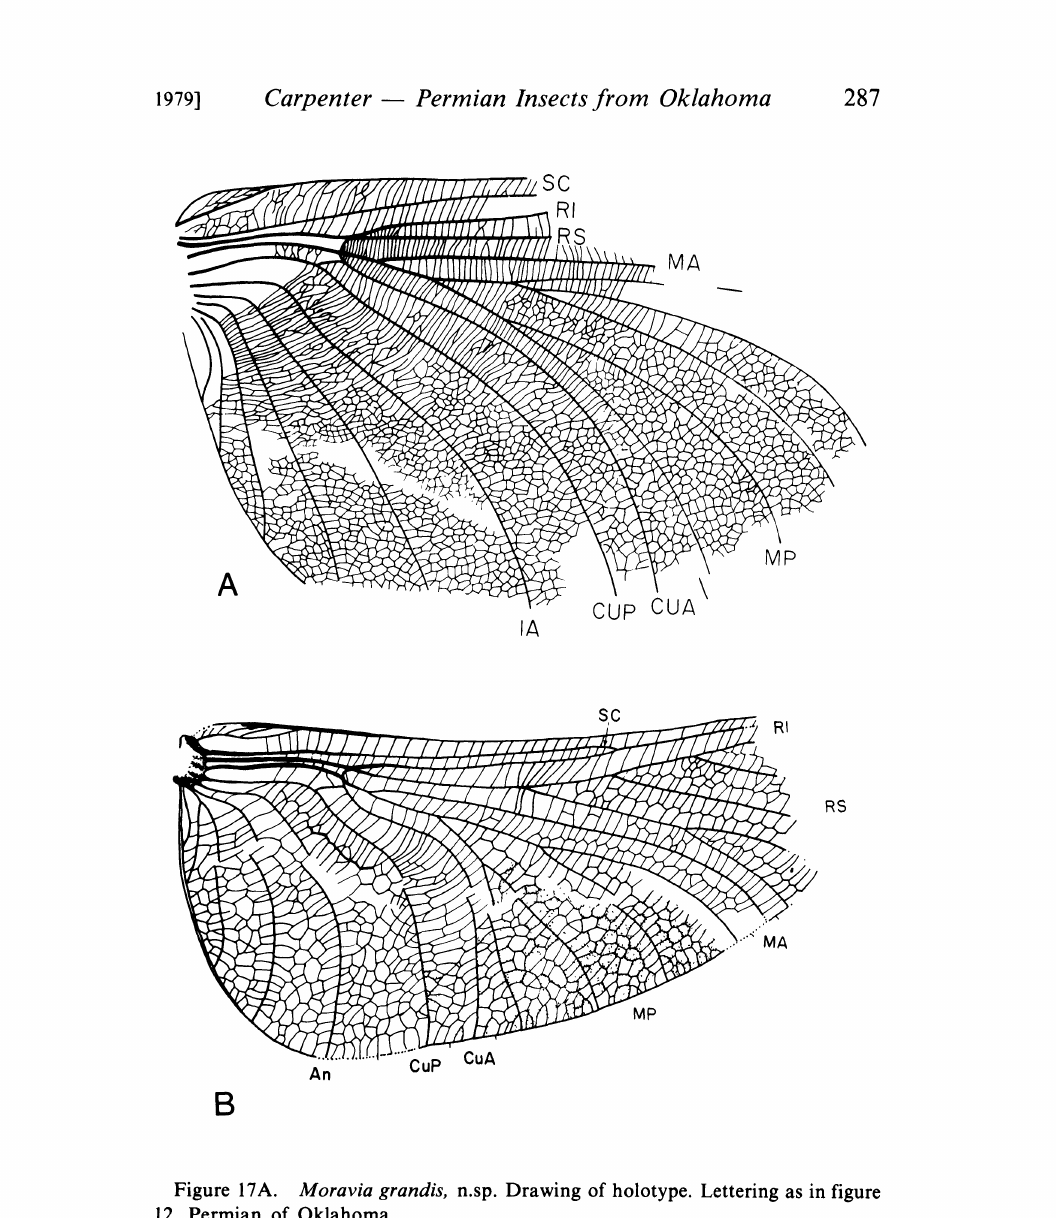
Figure 17A. Moravia grandis, n.sp. Drawing of holotype. Lettering as in figure 12. Permian of Oklahoma. Figure 17B. Moravia convergens Kukalova. Drawing of paratype (hind wing). Lower Permian of Moravia. [From Kukalova,